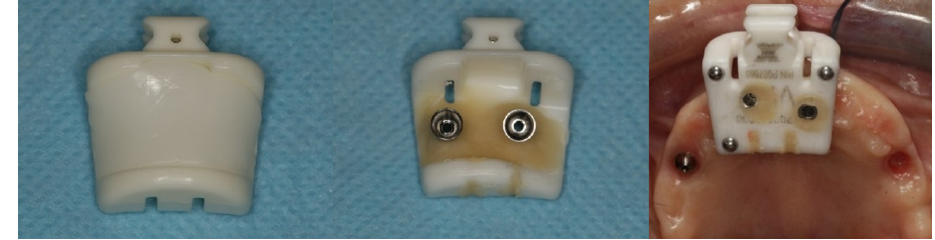
Figure 21. Perioperative photograph of the modified clip adapted from a conventional navigation clip for single and partial dentate cases.